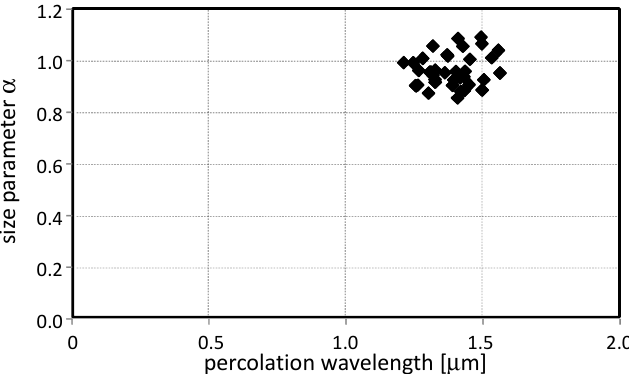
Figure 9. Correlation between the α size and the percolation wavelength. The small dispersion of the measures proves that the PM10 concentration in the museum varied very little with a small dispersion in size.